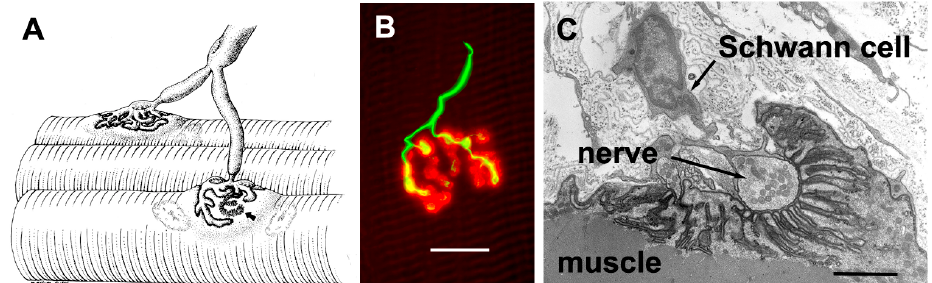
Figure 1. Mammalian neuromuscular junctions (NMJ) structure. ( A ) Diagram showing a motor axon which branches to innervate two muscle fibers at the NMJs. Note the extensive branching of the motor axon terminal. Arrow shows region where nerve has been removed, revealing postsynaptic folds (From Salpeter, 1986, with permission) [2]; ( B ) Human NMJ showing the nerve terminal (green, immunolabeling of synaptophysin and neurofilament protein) and the postsynaptic acetylcholine receptors (AChRs) (red, fluorescent tagged α -bungarotoxin). Note the swollen “boutons” of the nerve terminal, from which transmitter is released. Scale bar, 20 μ m; ( C ) Electron micrograph of a section through a single bouton. Note the extensive infolding of the postsynaptic muscle fiber membrane. Scale bar, 1 μ m.